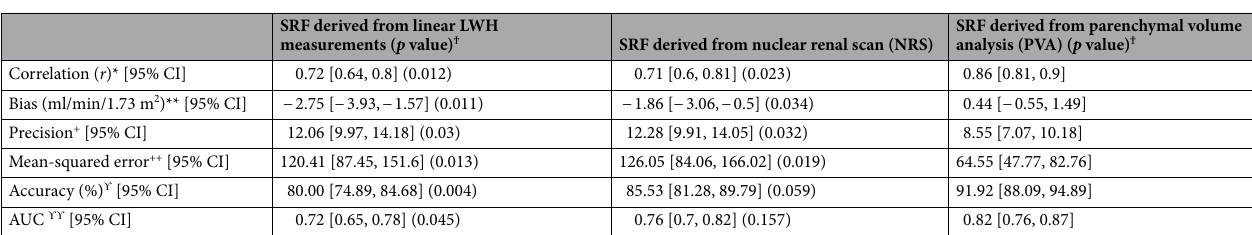
SRF derived from parenchymal volume analysis (PVA) ( p value)